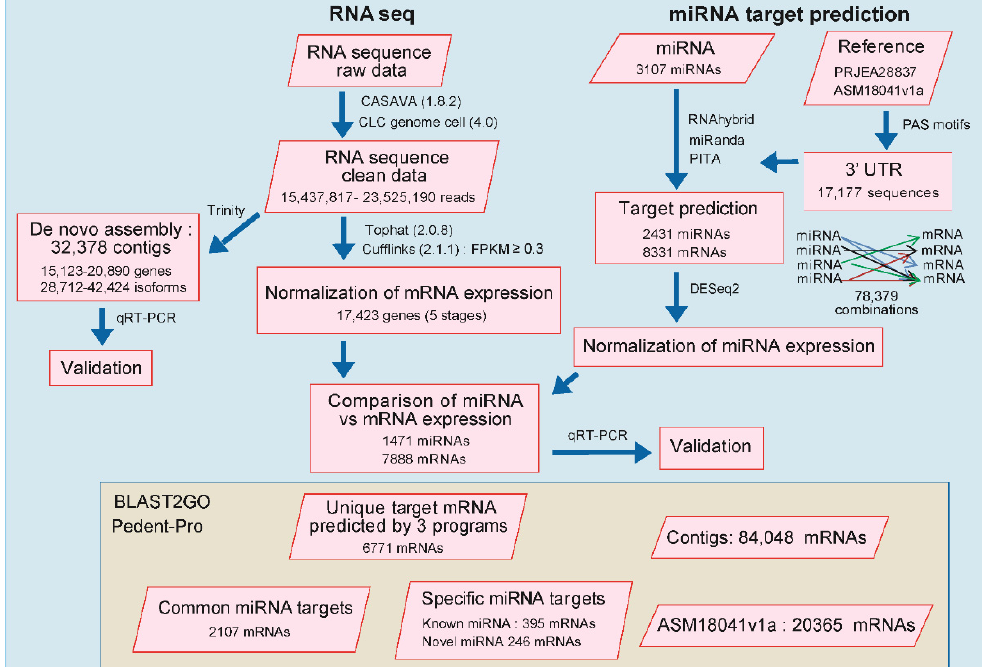
Figure 1. Flowchart representing the overall process of the current study. In silico analysis of miRNA-targeted mRNA prediction from the reference genome (ASM18041V1a) [2]; further combinations of miRNA-targeted mRNAs were elucidated. Illumina sequence data were used as the raw data; these data were cleaned using multiple software programs (RNAhybrid, miRanda, and PITA) and differentially expressed mRNAs were analyzed with a Venn diagram and heatmap. Expression levels of miRNA and mRNA based on sequencing results were normalized using DESeq2 and the fragments per kilobase of transcript per million mapped reads (FPKM) methods, respectively. Further miRNA-targeted mRNAs were validated through qRT-PCR for all developmental stages of M. incognita . Sequencing results were annotated with BLAST2GO using data for specific, common, and unique miRNA-targeted mRNAs.